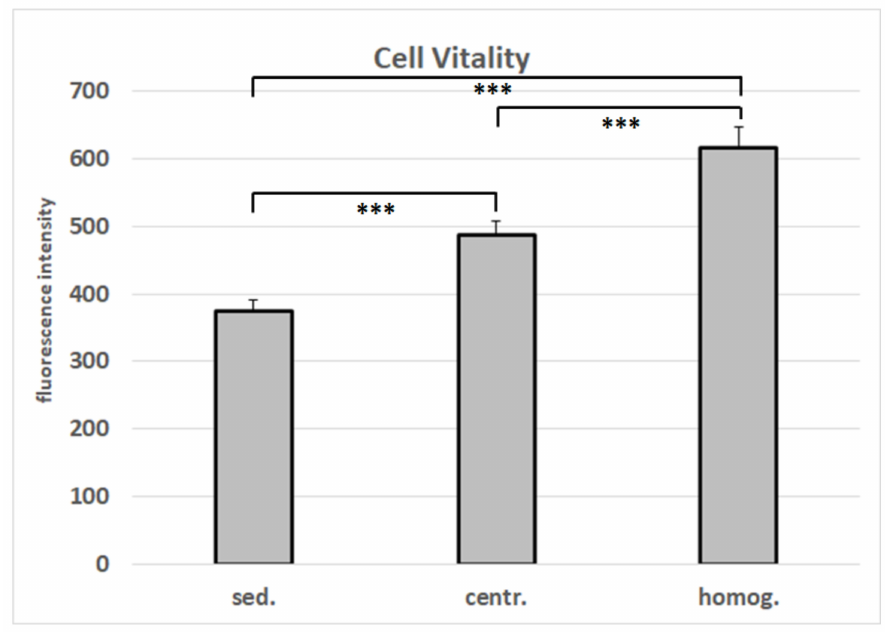
Figure 6. Vitality of cells isolated from varying tissue processings. Mean values and standard deviations are shown. Student’s t -test was used to assess statistical significance (*** p < 0.001). (sed.: sedimented; centr.: centrifuged; homog.: homogenized). The cells isolated from the differently processed tissues are positive for MSC marker CD44 (Figure